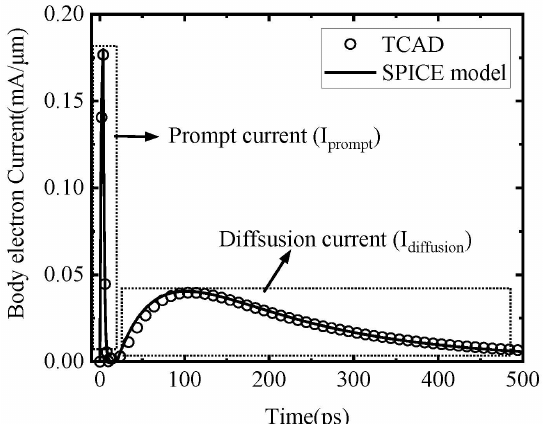
Figure 6. Comparison between the TCAD simulation results and the SPICE model of the prompt current and the diffusion